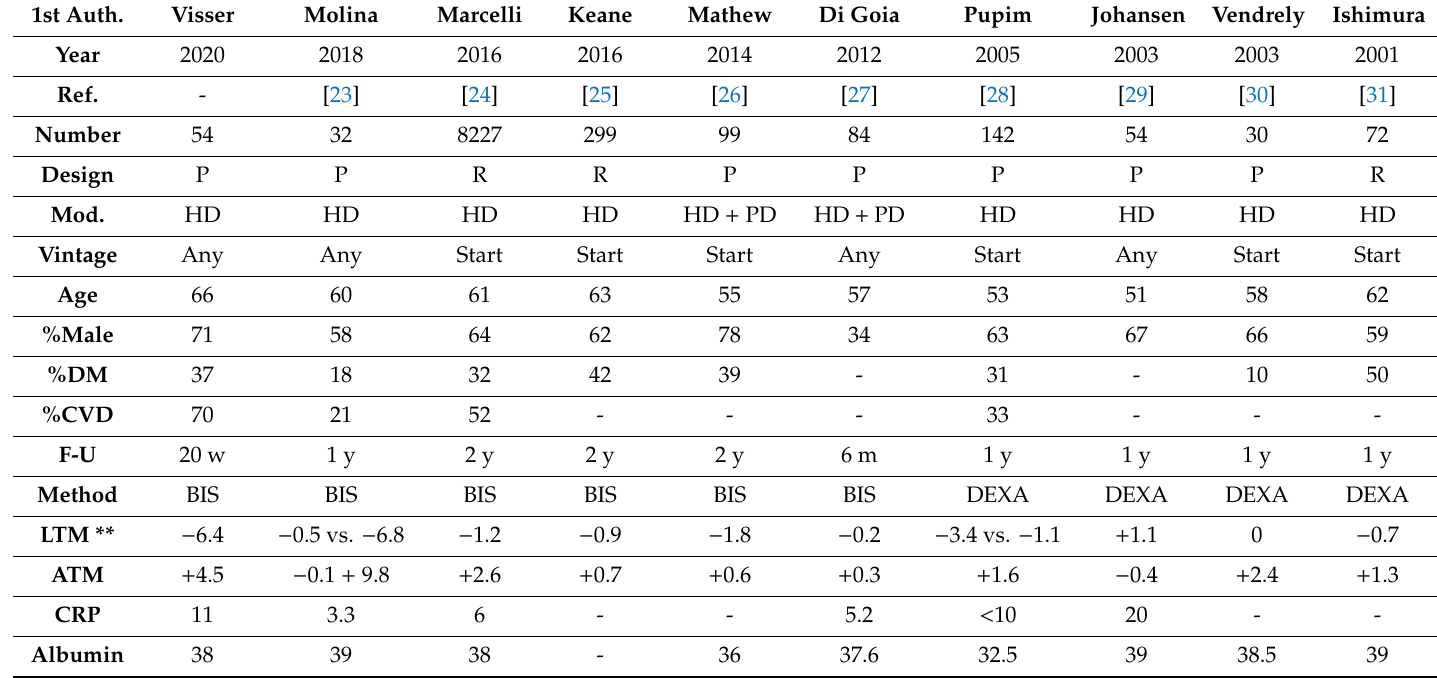
Table 5. Overview of studies on change in body composition over time in dialysis patients *. 1st